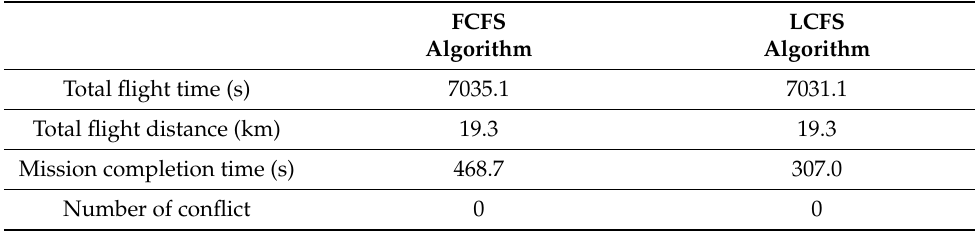
Table 3. Comparison between the FCFS and LCFS algorithms for the 1-to- M